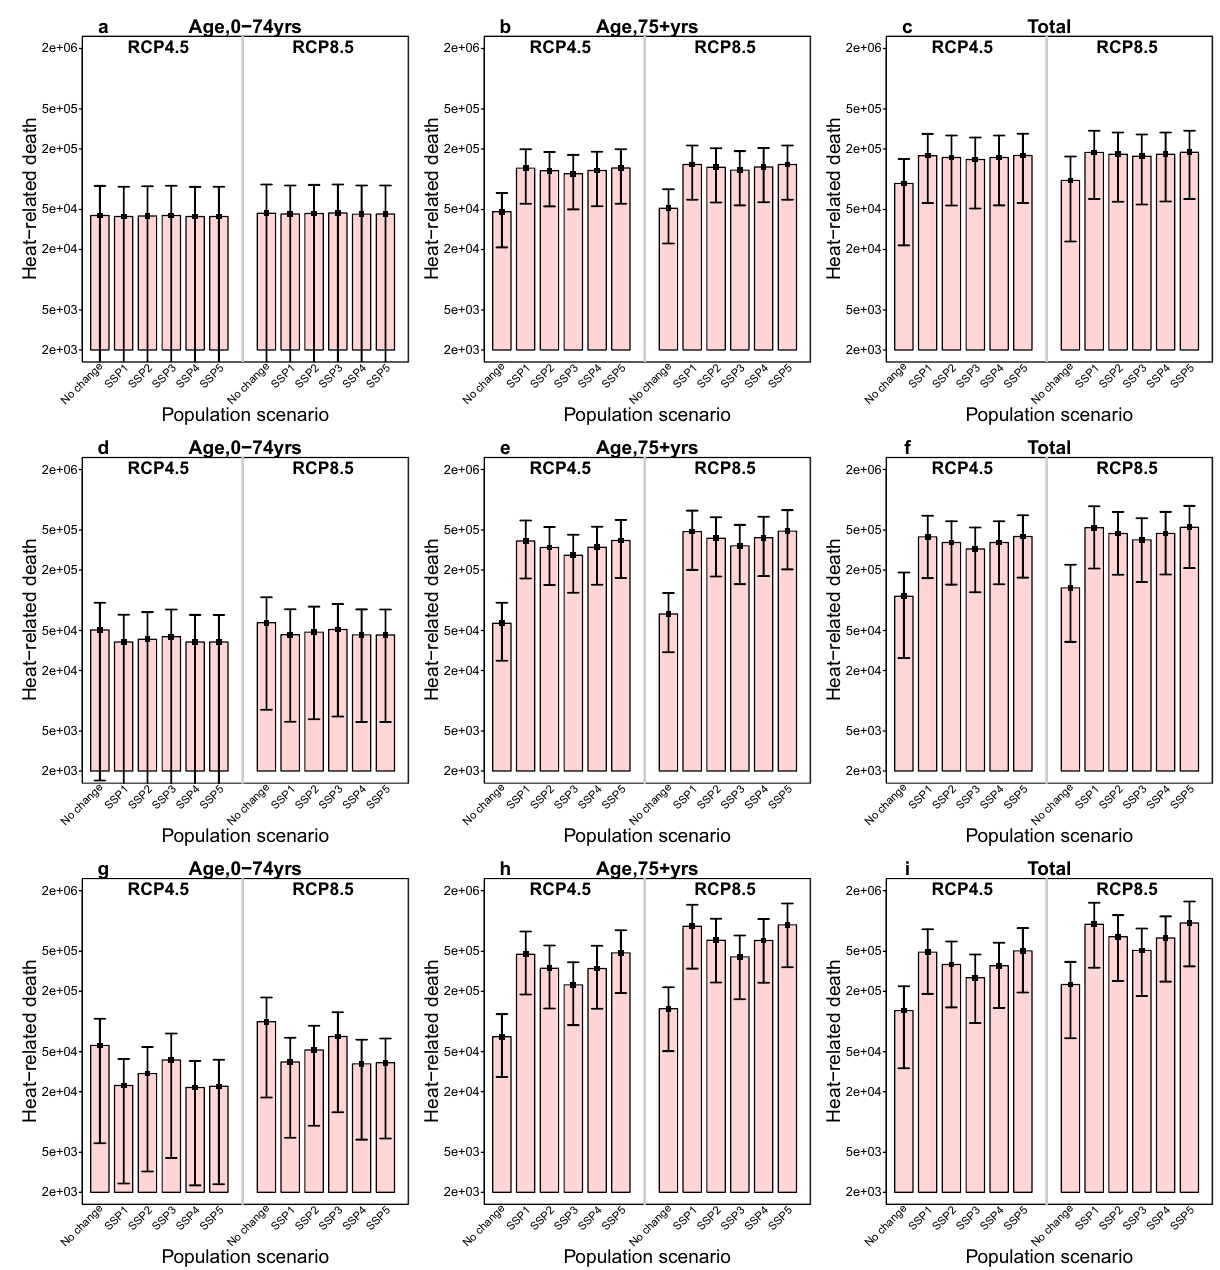
Fig. 4 The number of heat-attributable deaths by period, age, and population scenario in China. a – c Respectively show the number of heat-attributable deaths (red bar) in the 2030 s for different age groups under six population scenarios (no change, SSP1 – SSP5). d – f Respectively show the number of heat- attributable deaths in the 2050s by age and population scenario. g – i Respectively show the number of heat-attributable deaths in the 2050s by decade, age, and population scenario. The black vertical segments represent the 95% empirical con fi dence interval. A distributed lag nonlinear model was used for estimating district/county-speci fi c temperature – mortality associations with 14 days of lag adjusted for time trends and day of the week, which were pooled in a multivariate meta-analysis. Then, based on the age-speci fi c temperature – mortality association and age-speci fi c projected population, estimates of the attributable number of deaths due to high temperature, de fi ned as temperatures above the optimum temperature, were calculated for different age groups under the fi ve SSPs. Monte Carlo simulations generating 1000 samples were computed to produce the empirical con fi dence interval. Source data are provided as Supplementary Data